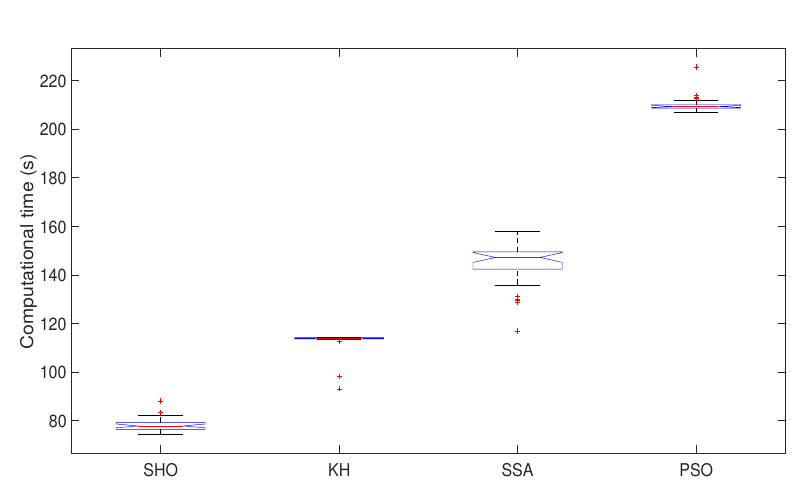
Figure 2. F1 score box plot.